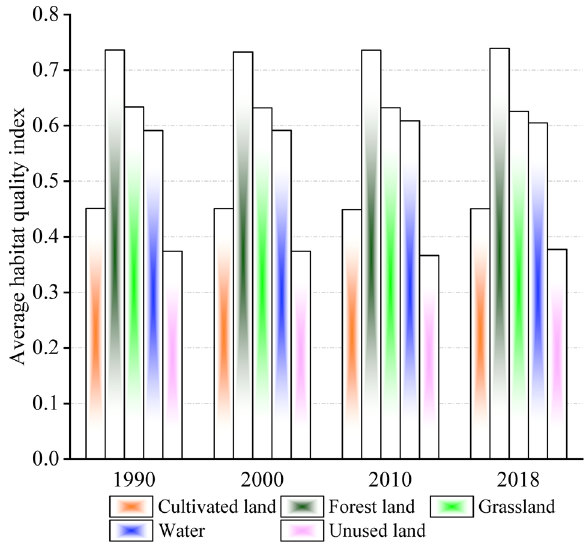
Figure 6. Average HQ indices of different land-use